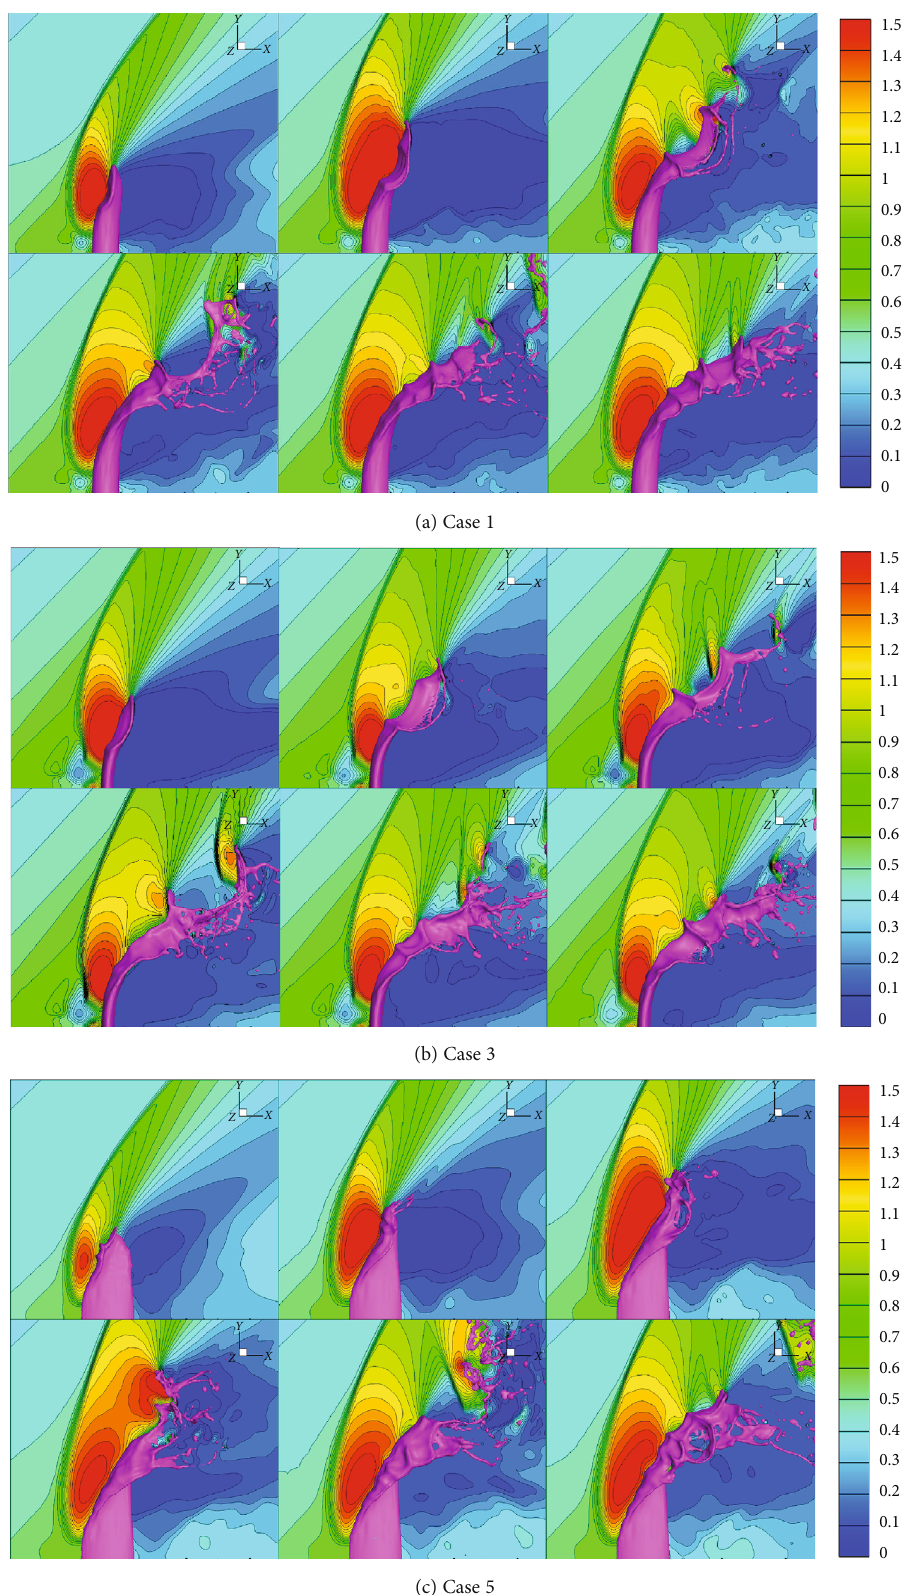
Figure 4: Morphology of liquid jet primary breakup with P ∗ contours in slice z = 0 for three AR, Δ t = 8 μ